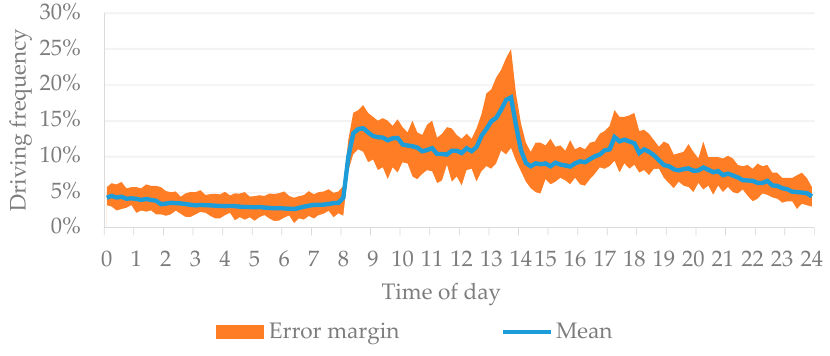
Figure 4. Distribution of driving frequency of EVs on weekdays. Note: The error margin is standard deviation of observed value.